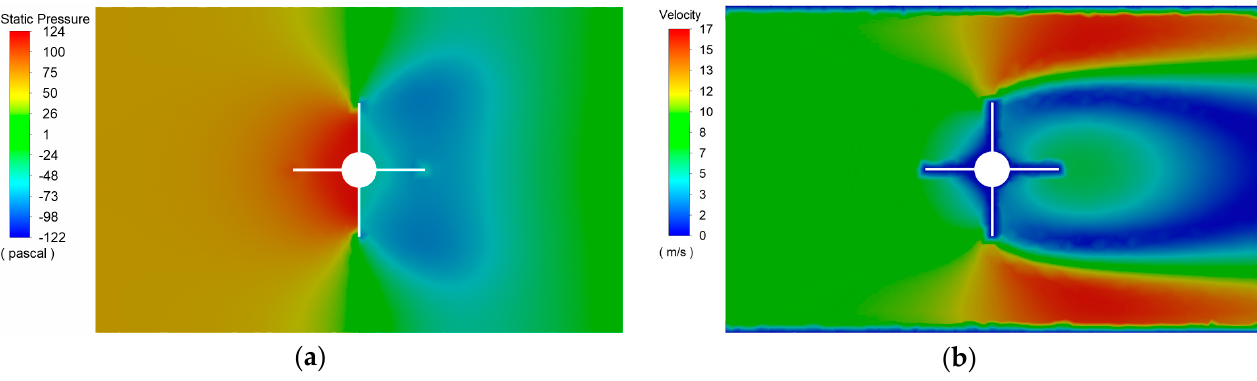
Figure 11. ( a ) Pressure distribution; ( b ) Velocity distribution for the tube with 4 fins (case c3).